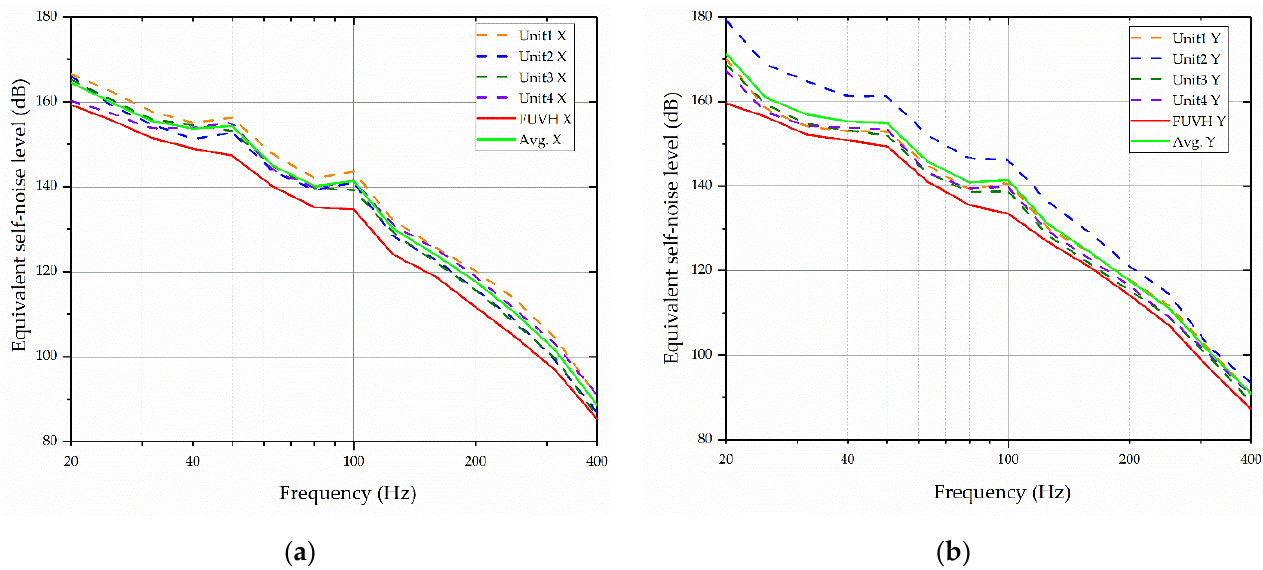
Figure 16. The results of equivalent self-noise level: ( a ) the result of X channel and ( b ) Y channel. As shown in Figure 16a, in X channels, the equivalent self-noise level of the FUVH is higher than the mean value of its four units, with an average difference of 5.18 dB. As of the FUVH and the mean value of its four units is 5.14 dB. According to the results, it is clear that the FUVH has a lower equivalent self-noise level compared to its four